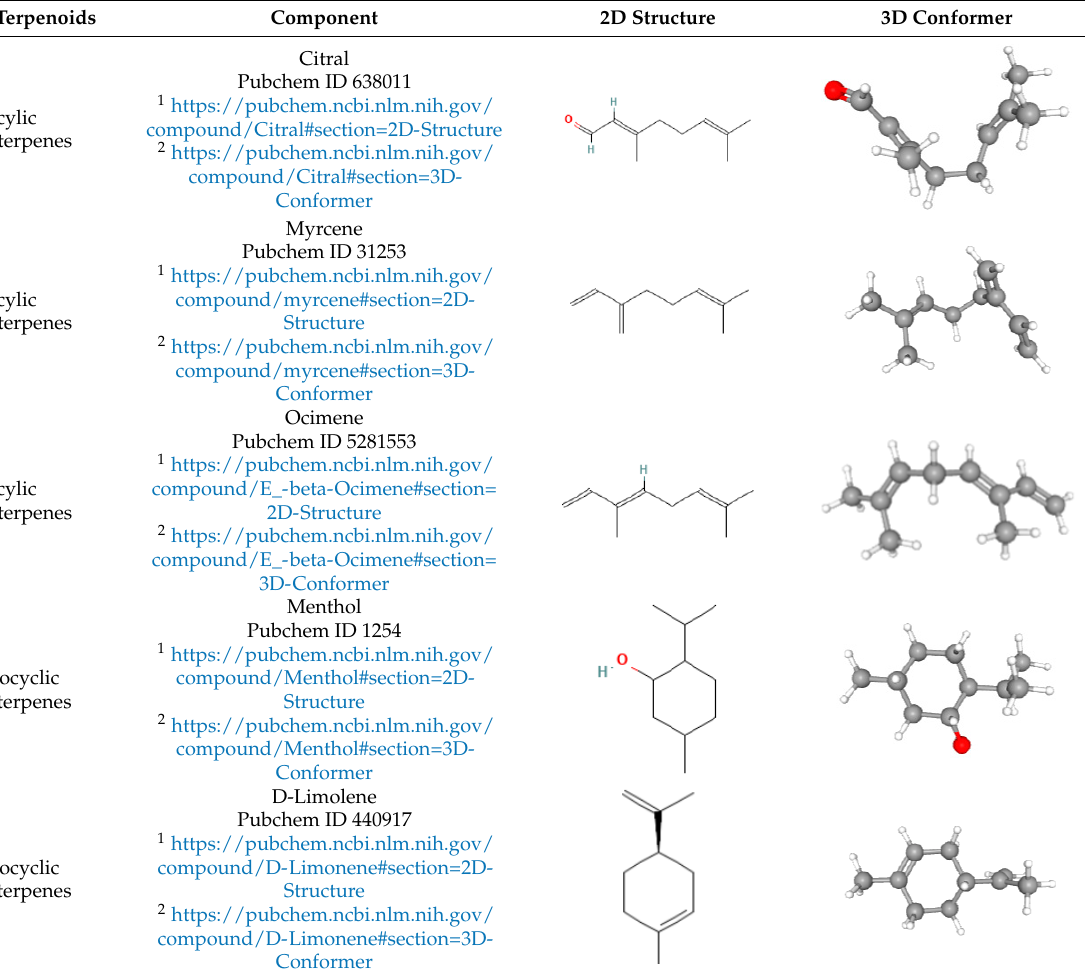
Table 1. Structure of the representative volatile aromatic terpenes. Structures have been adapted